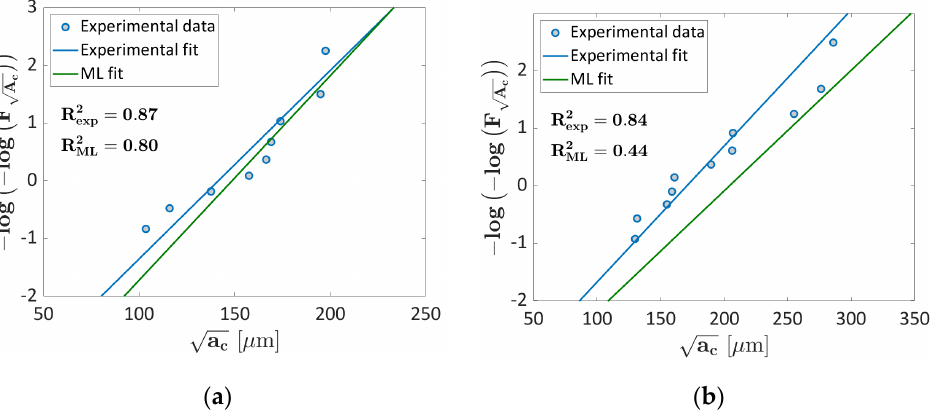
Figure 11. Analysis of the capability of ML LEVD of predicting size effect: ( a ) Gumbel plot for k = 2, showing the validation fold obtained through tests on horizontal specimens with a risk volume of 2300 mm 3 . ( b ) Gumbel plot for k = 3, showing the validation fold obtained through tests on vertical specimens with a risk volume of 2300 mm 3 .